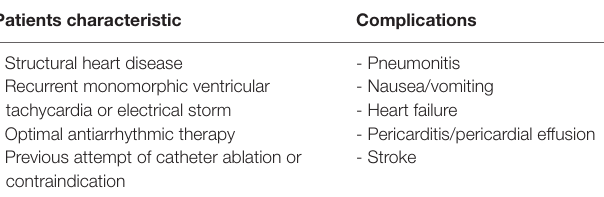
TABLE 2 | Patients characteristic eligible to STAR and possible complications.